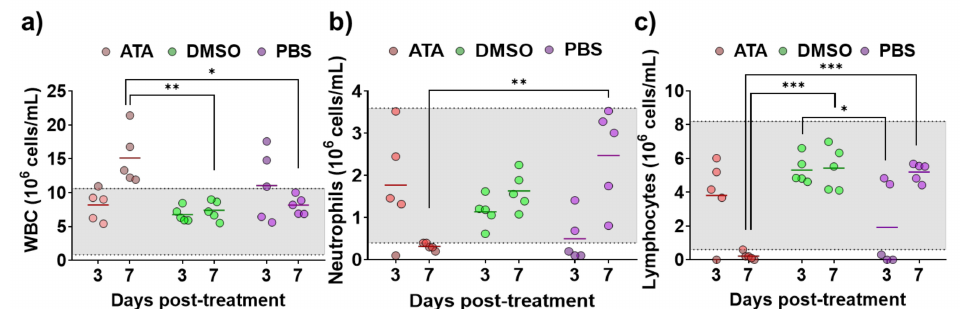
Figure 4. Toxicity of ATA in uninfected mice. Evaluation of blood parameters in samples taken from IFNAR ( − / − ) mice treated with ATA (red), DMSO (green), and PBS (purple) to determine the number of white blood cells (WBC) ( a ), neutrophils (Neu) ( b ), and lymphocytes (Lym) ( c ). Samples were evaluated with a multiparameter autohematology analyzer at 3 and 7 days post-treatment. * p < 0.05, ** p < 0.005, *** p < 0.0005, using two-way ANOVA. Horizontal lines indicate the means. Gray shadows indicates reference values for selected hematological